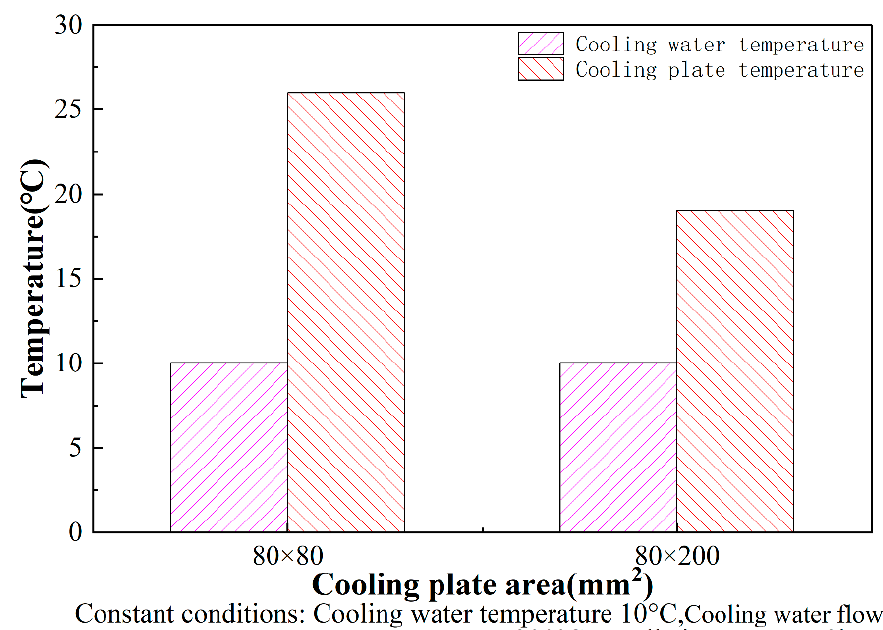
Figure 8. Effect of cooling plate area on cooling plate temperature.